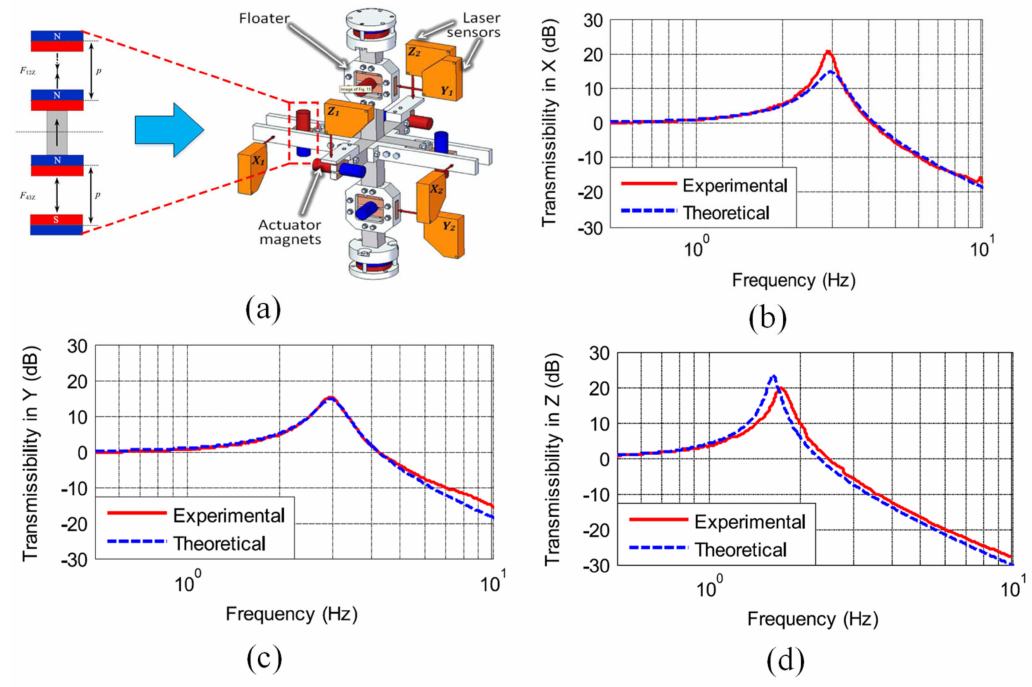
Figure 18. Robertson et al. [82] proposed a 6-DOF QZS isolator with magnetic levitation: ( a ) vibration isolator structure; ( b – d ) show the vibration transmissivity in the X/Y/Z direction, respectively. Figures adapted with permission from Ref. [82]. Copyright 2015, copyright Zhu,